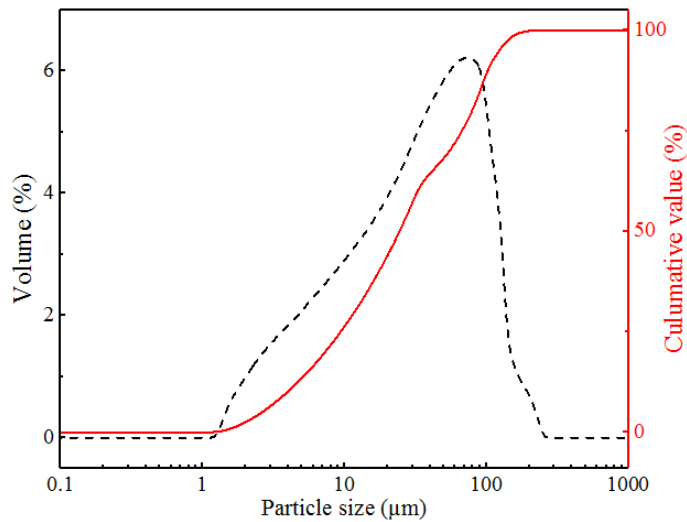
Table 3. The physical characteristics of MCS.